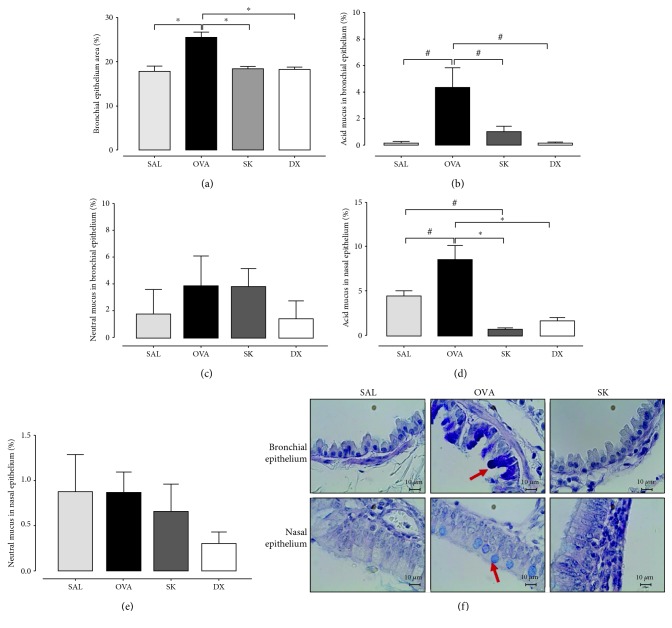
Bronchial epithelium area and acid mucus production were reduced by the sakuranetin and dexamethasone treatments compared with the OVA group: (a) bronchial epithelium area; (b) acid mucus in bronchial epithelia; (c) neutral mucus in bronchial epithelia; (d) acid mucus in nasal epithelia; (e) neutral mucus in nasal epithelia. (f) Images represent lung and nasal septal slices stained with PAS+AB from the SAL, OVA, SK, and DX groups at a magnification of ×20. ∗p < 0.001 and #p < 0.05. Data represent mean ± SEM from 5 to 8 mice per group.